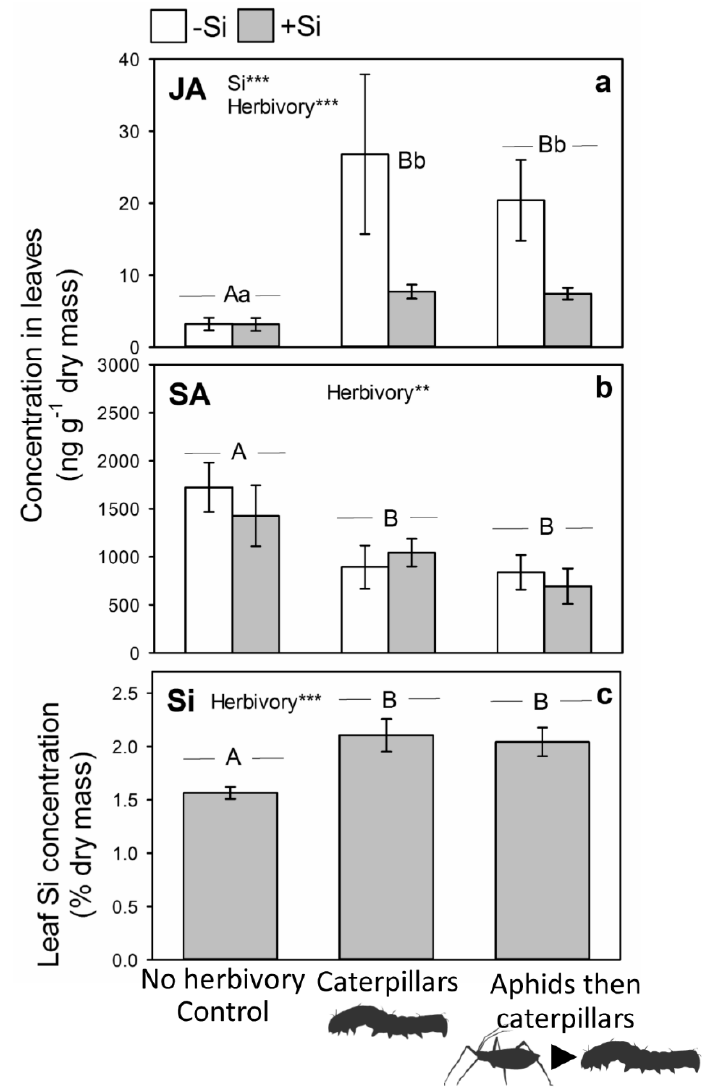
Figure 3. Impacts Si and previous aphid feeding on leaf ( a ) JA, ( b ) SA and ( c ) Si concentrations